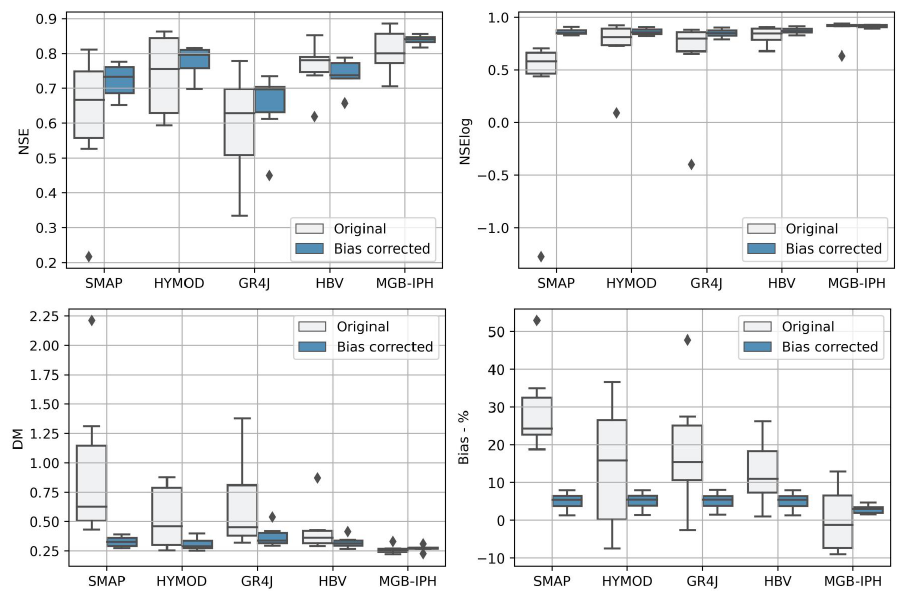
Figure 9. Boxplots of deterministic metrics for the original and corrected simulated data for the vaildation period.